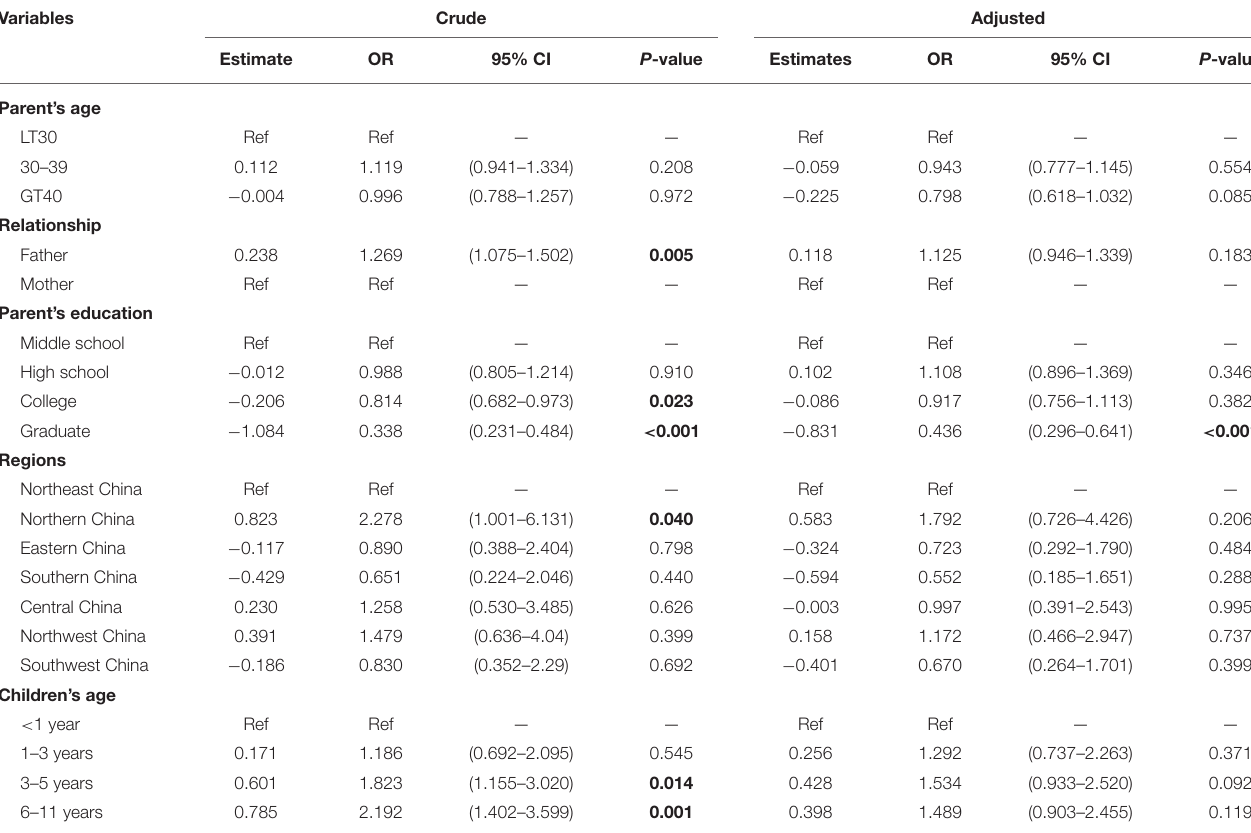
The bold font indicates these variables reached statistical